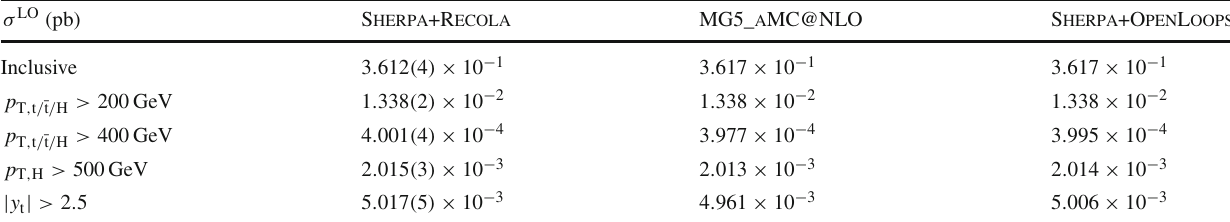
Table 5 Integrated cross sections for pp → t ¯ tH at LO for a centre- √ s = 13TeV calculated with Sherpa + Recola , of-mass energy of MadGraph5_aMC@NLO , and Sherpa +O pen L oops for the set-up of